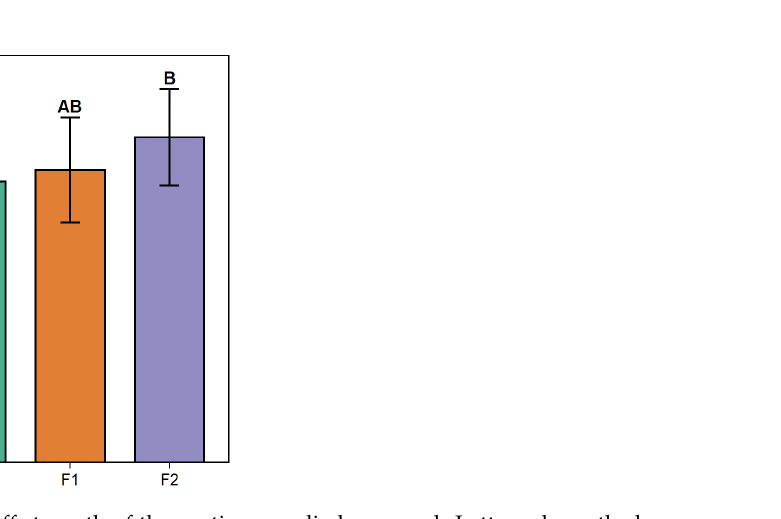
Figure 8. Pull-off strength of the coatings applied on wood. Letters above the bars correspond to the groups determined in the Tukey comparison test after the ANOVA analysis (α = 0.05). Groups having a letter in common are not significantly different.